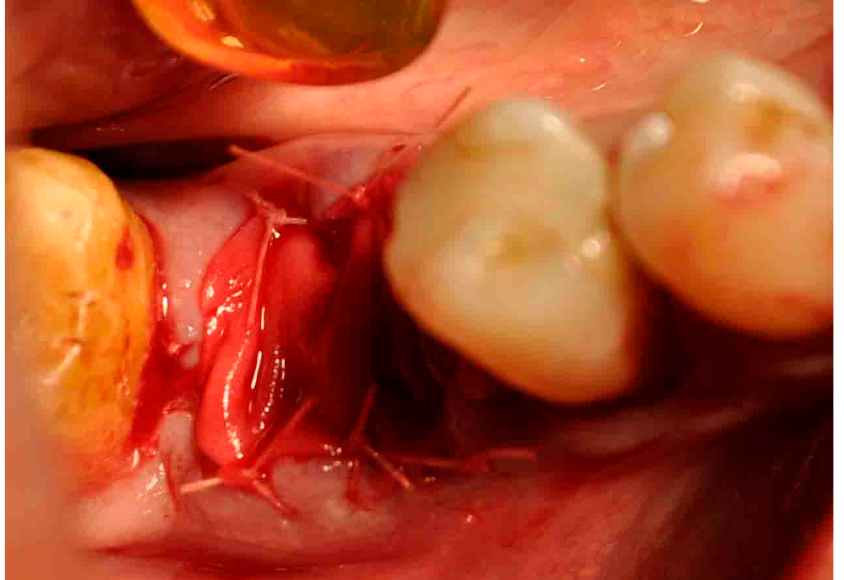
Figure 3. Postoperative socket with sponge of deproteinized bovine bone + collagen 100 mg covered with resorbable collagen membrane 16 mm × 22 mm stabilized with 6 6/0 resorbable sutures. Sutures were removed at 21 days after surgery.